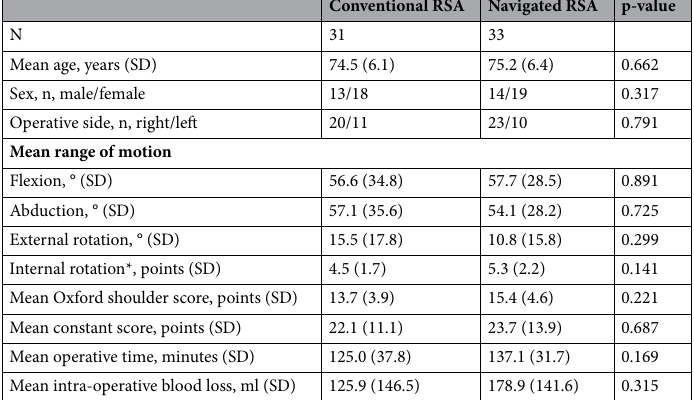
Table1. Patient demographics. n number, SD standard deviation. *Internal rotation: In accordance with the Constant score, 0, lateral thigh; 2, buttock; 4, lumbosacral junction; 6, L3 (waist); 8, T12; 10, T7 (interscapular). p < 0.05 is considered statistically significant.